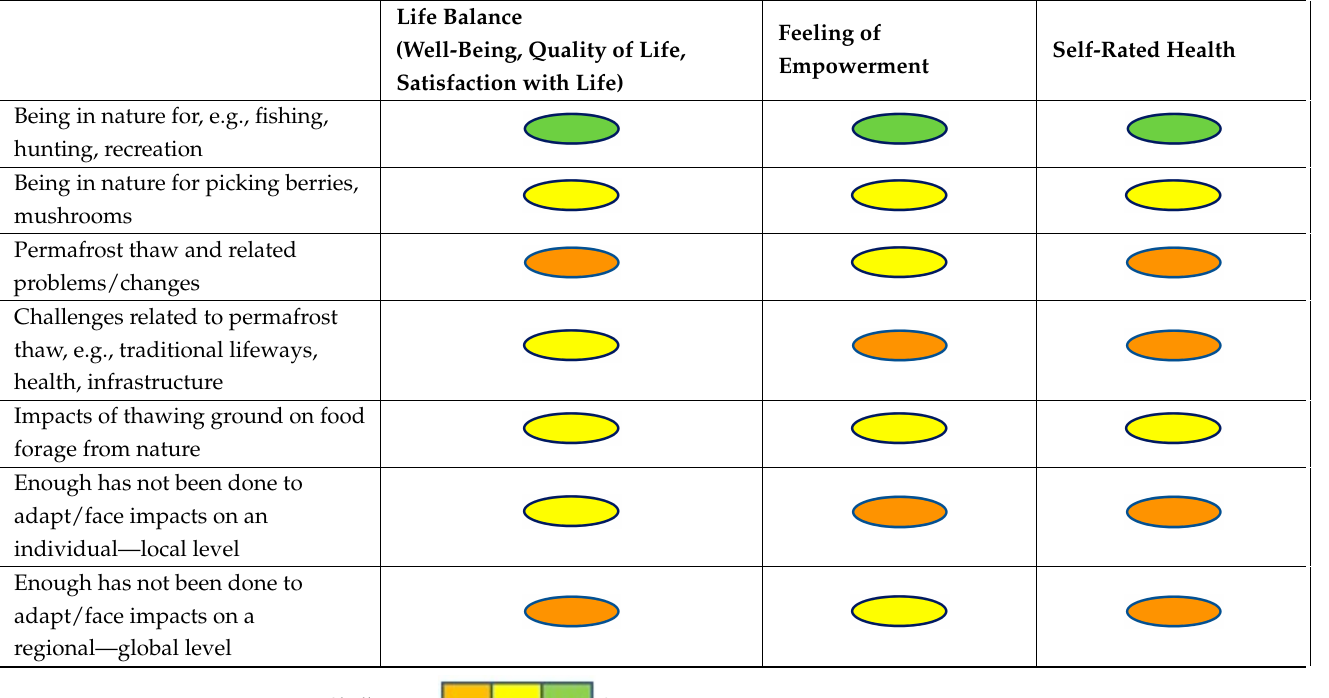
Table 5. Interpretive summary of the main results: Descriptive relationships between themes (formu- lated from perceived environment and adaptation factors) and life balance, feeling of empowerment, and self-rated health. Life Balance (Well-Being, Quality of Life, Satisfaction with Life)